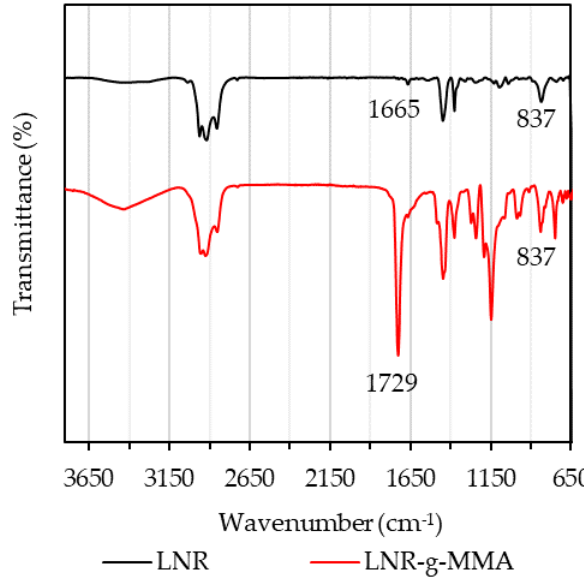
Figure 1. FTIR spectra of the LNR and LNR−g−MMA.